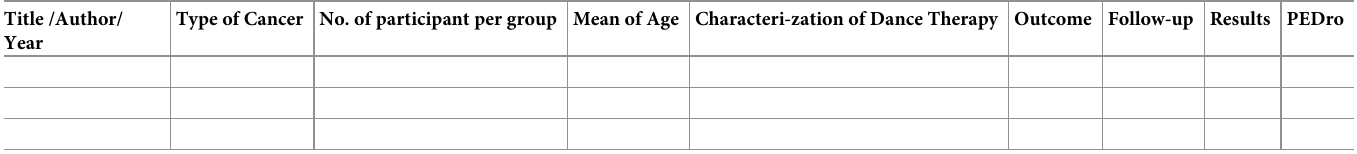
Table 2. Study characteristics related to the configuration: Title, authors, years; type of cancer; number of participant per group; mean of age; characterization of dance therapy (protocol details); outcome; follow-up (simplified); results; score the PEDro